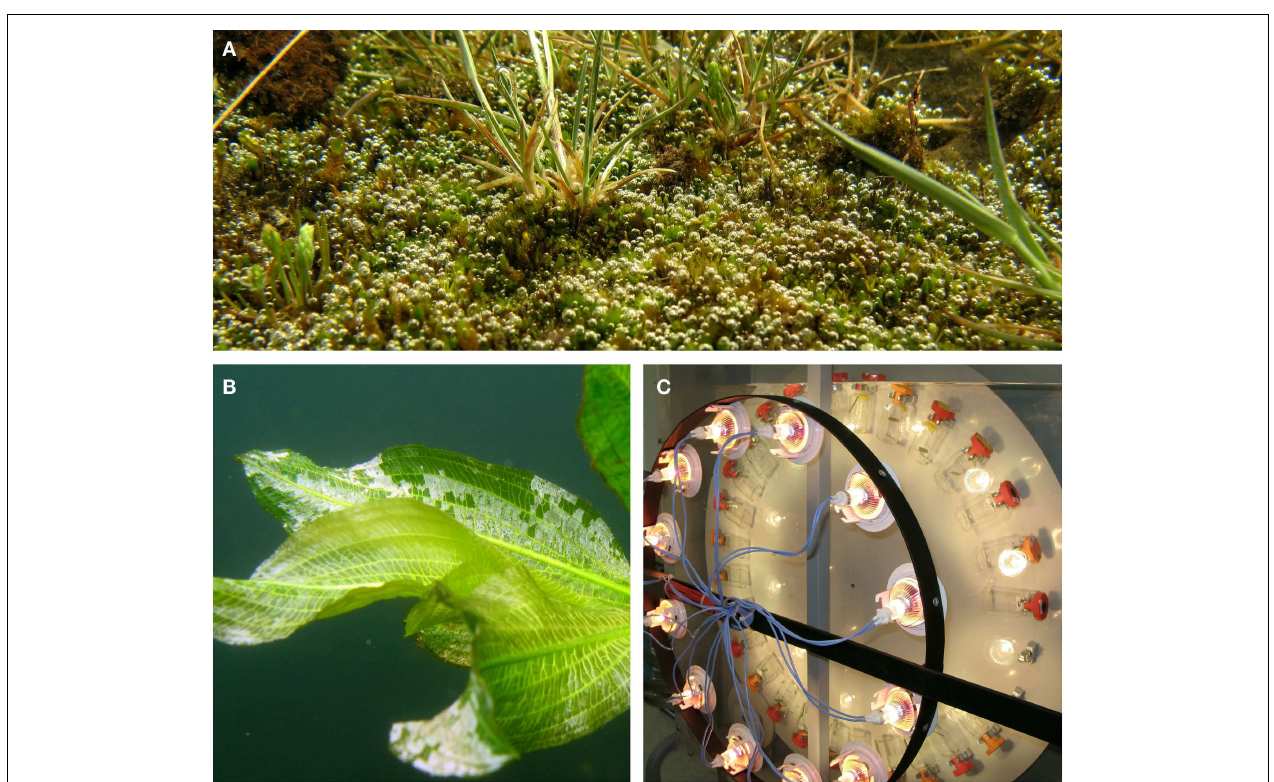
that retain a thin gas film when under water, evident as a silvery reflecting surface. In (B) , high pH on the adaxial leaf surfaces following extensive underwater photosynthesis has resulted in precipitation of CaCO 3 (See “Challenges UnderWater – Reduced Gas Diffusion and Light Penetration”). Photos: a shallow puddle on Öland, Sweden (A) , the bicarbonate rich (1.8mmol DIC L − 1 ) Lake Slåen, Denmark (B) and the custom built wheel incubator by Ray Scott at the University ofWestern Australia (C) ; photos by Ole